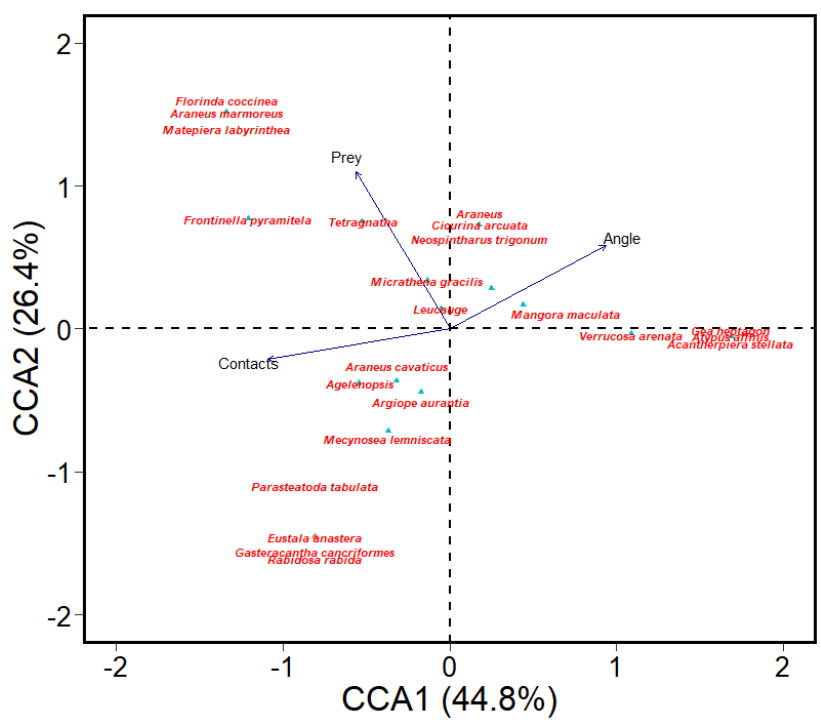
Figure 2. Canonical correspondence analysis (CCA) biplot showing the relationship between spiders and environmental variables (number of contact points (branches), prey abundance enumerated from webs and angle of webs). Samples were collected from parks in Memphis, TN in the summer months of 2022. Blue triangles denote species abundances.